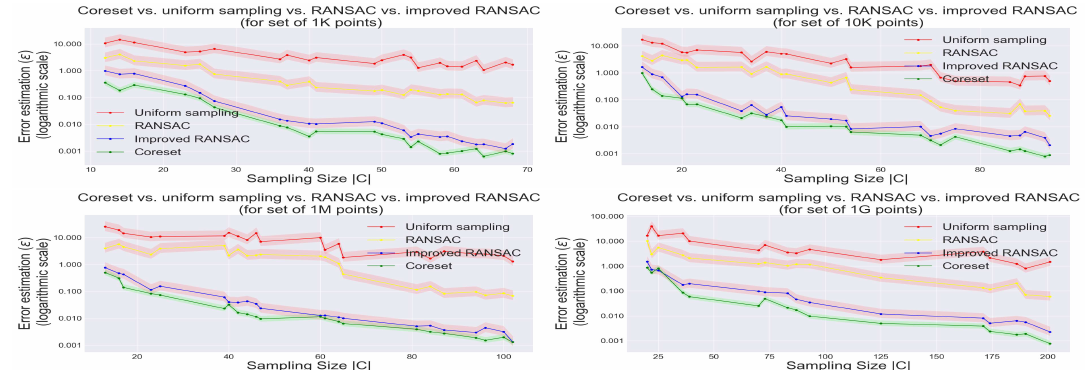
Figure 6. The 4D experiments result. The following four graphs show comparison results between coreset sampling by our algorithm with uniform sampling with the same amount of sample data, compared to the RANSAC algorithm (on the full set and on the coreset) that runs at the same time. Each graph displays results for a differently-sized data set.